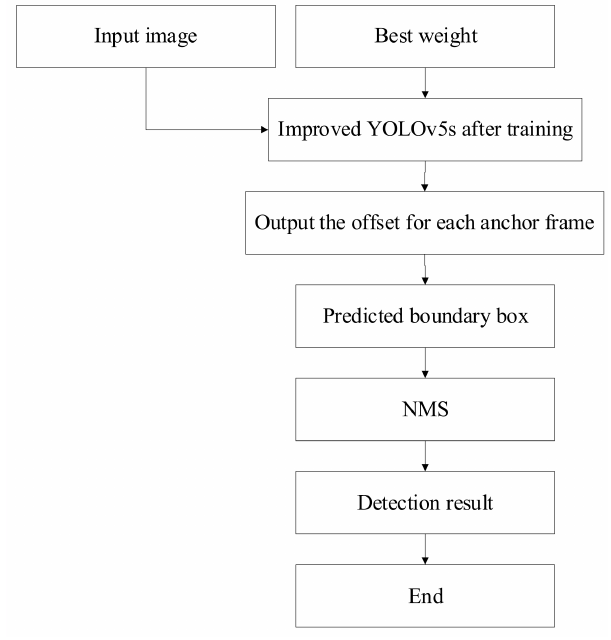
Figure 10. Inference process of the Improved YOLOv5s.